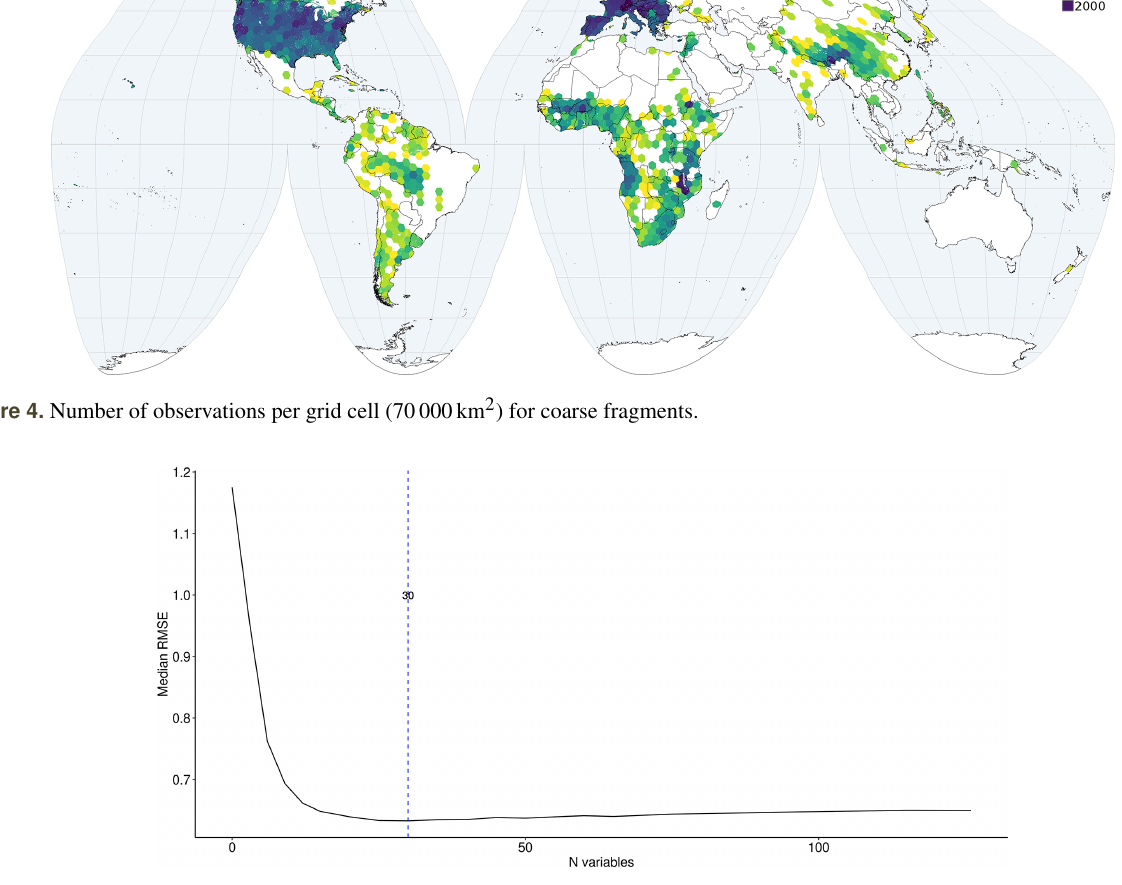
areas. Using spatial cross-validation as suggested by